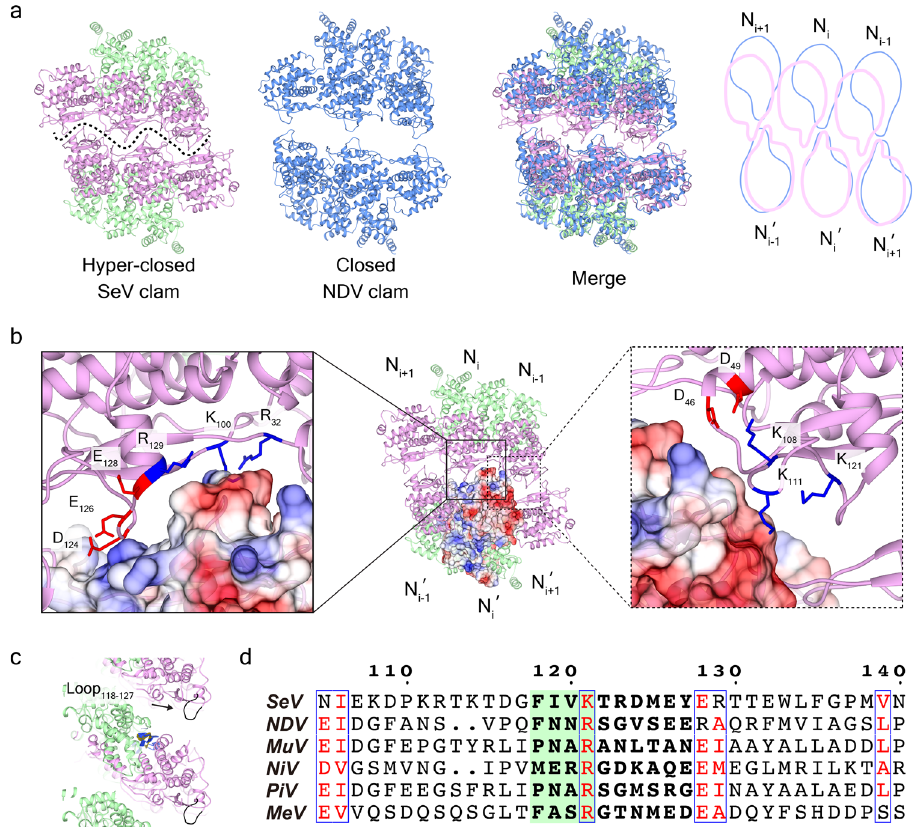
Fig. 4 Hyper-closed clam-shaped joint in double-headed SeV nucleocapsid. a Hyper-closed SeV clam-shaped assembly compared with NDV clam- shaped structure. The interface between opposite protomers in SeV clam-shaped structure is depicted in the dashed curve line. b Interface analysis of SeV clam-shaped structure. Two contact sites are marked in the solid box (left) and dotted box (right), respectively. Positively charged residues in the upper helix are labeled and the contour surface of electrostatic potential is shown in the opposite rung. c Loop 118 – 127 is not involved in the assembly of the helical stem. d Sequence alignment of Loop 118 – 127 of SeV nucleoprotein in members of paramyxoviruses. The critical residues from 118 to 121 are shaded in green.